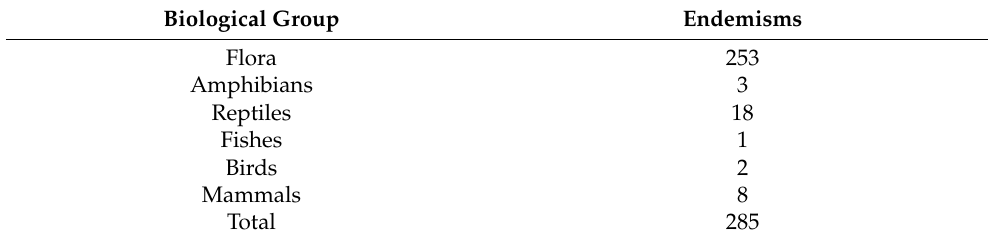
Table 2. Endemic taxa by biological group, Sierra de San Miguelito, San Luis Potosi. Biological Group Endemisms Flora 253 Amphibians 3 Reptiles